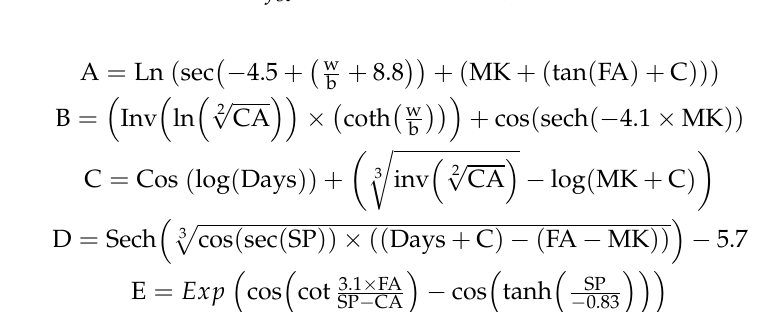
Figure 10. DR values of GEP I, ANN I, and RF I for ( a ) training set and ( b ) testing set. The high prediction and generalization capability of RF I as compared with GEP I is in agreement with the study by Mohsin et al. [95]. They modelled the f (cid:48) geopolymer concrete by using GEP and RF. In case of RF model, the values of R for training and testing set were 0.98 and 0.99, respectively, while in case of the GEP model, these values were 0.86 and 0.96 for the training and testing sets,